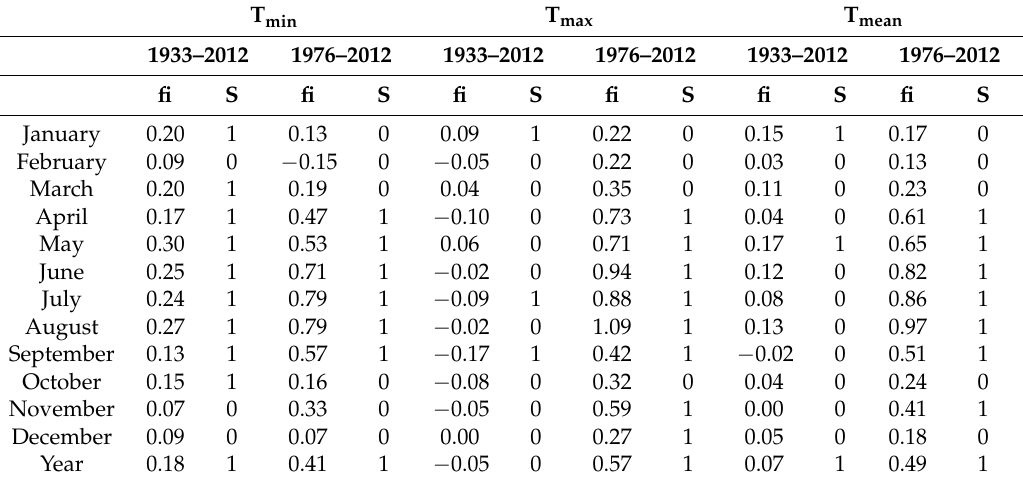
Table 3. Monthly and annual minimum temperature (T min ), maximum temperature (T max ) and mean temperature (T mean ) trend gradients as evaluated by the Theil-Sen estimator ( β [ ◦ C/decade]) and trend significance, at 95% confidence level, S (0, no trend, 1, trend exists) for the Salento area: whole